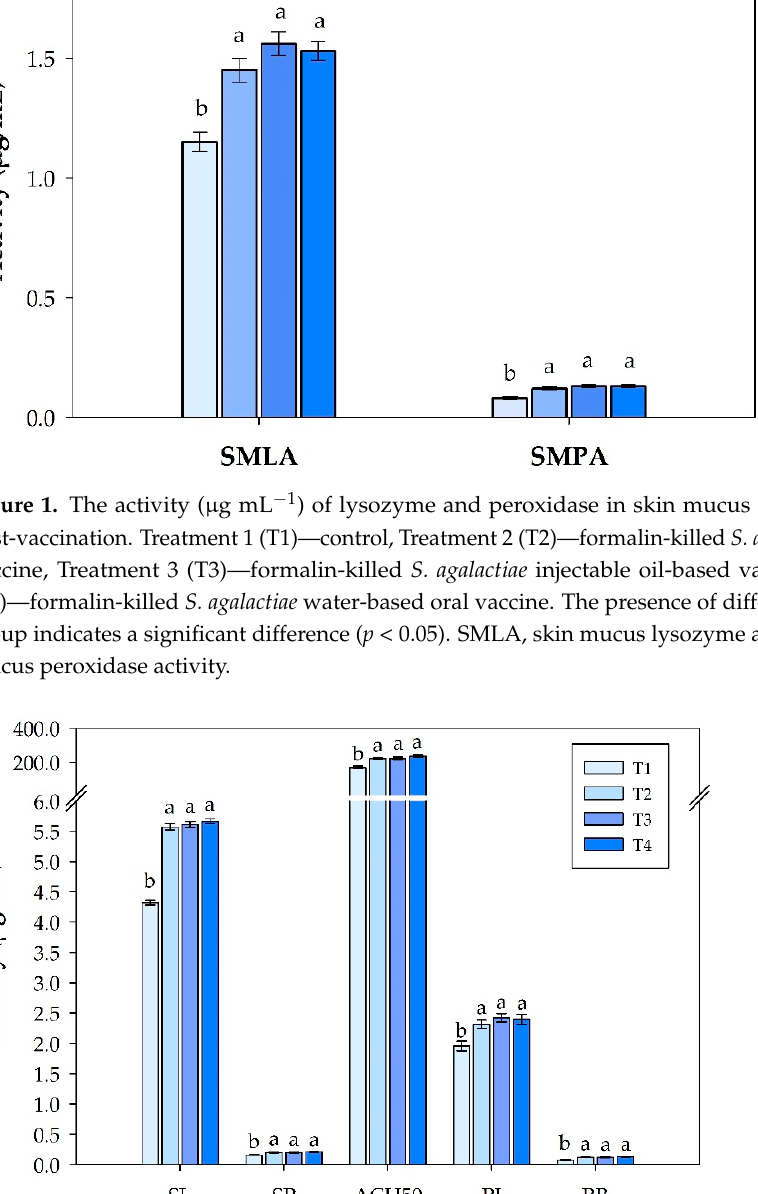
Figure 1. The activity ( μ g mL − 1 ) of lysozyme and peroxidase in skin mucus of Nile tilapia 15 d post ‐ vaccination. Treatment 1 (T1)—control, Treatment 2 (T2)—formalin ‐ killed S. agalactiae immersion vaccine, Treatment 3 (T3)—formalin ‐ killed S. agalactiae injectable oil ‐ based vaccine, Treatment 4